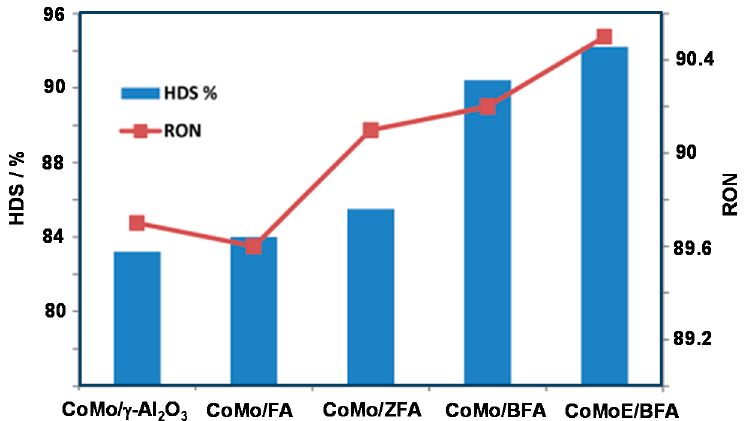
Figure 14. Catalytic performance of the CoMo/BFA and CoMoE/BFA catalysts in relation to the reference catalysts CoMo/ γ‐ Al 2 O 3 , CoMo/FA and CoMo/ZFA in the hydrodesulfurization (HDS) of full range fluid catalytic cracking (FCC) gasoline; FA—FDU ‐ 12 mixed with γ‐ Al 2 O 3 ; ZFA—Zr incorporated FDU ‐ 12 mixed with γ‐ Al 2 O 3 , BFA—Beta/FDU ‐ 12 mixed with γ‐ Al 2 O 3 . Adapted with permission from [36]. Copyright Royal Society of Chemistry, 2016.